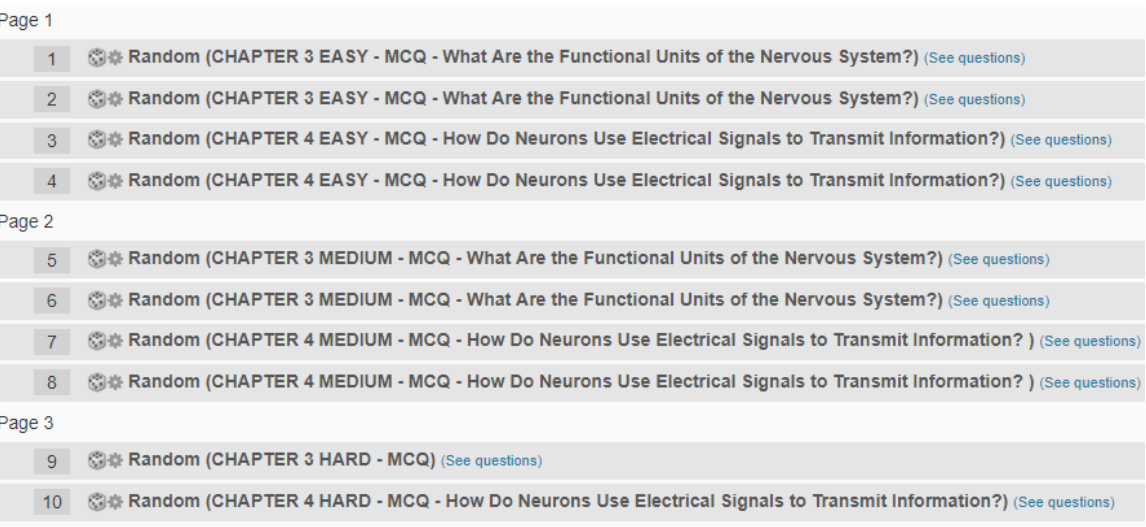
Figure A2. Typical structure of a level 1 test in Moodle consisting of 10